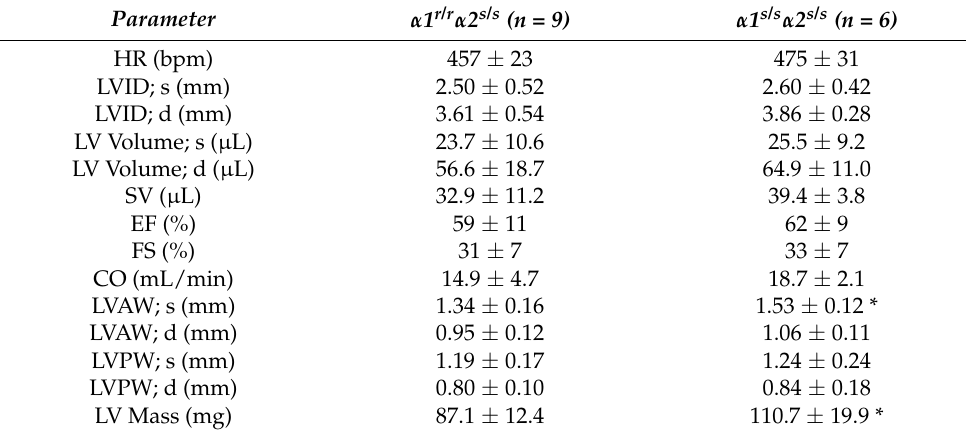
Table 1. Echocardiographic parameters in α 1 r/r α 2 s/s and α 1 s/s α 2 s/s mice. * p < 0.05.